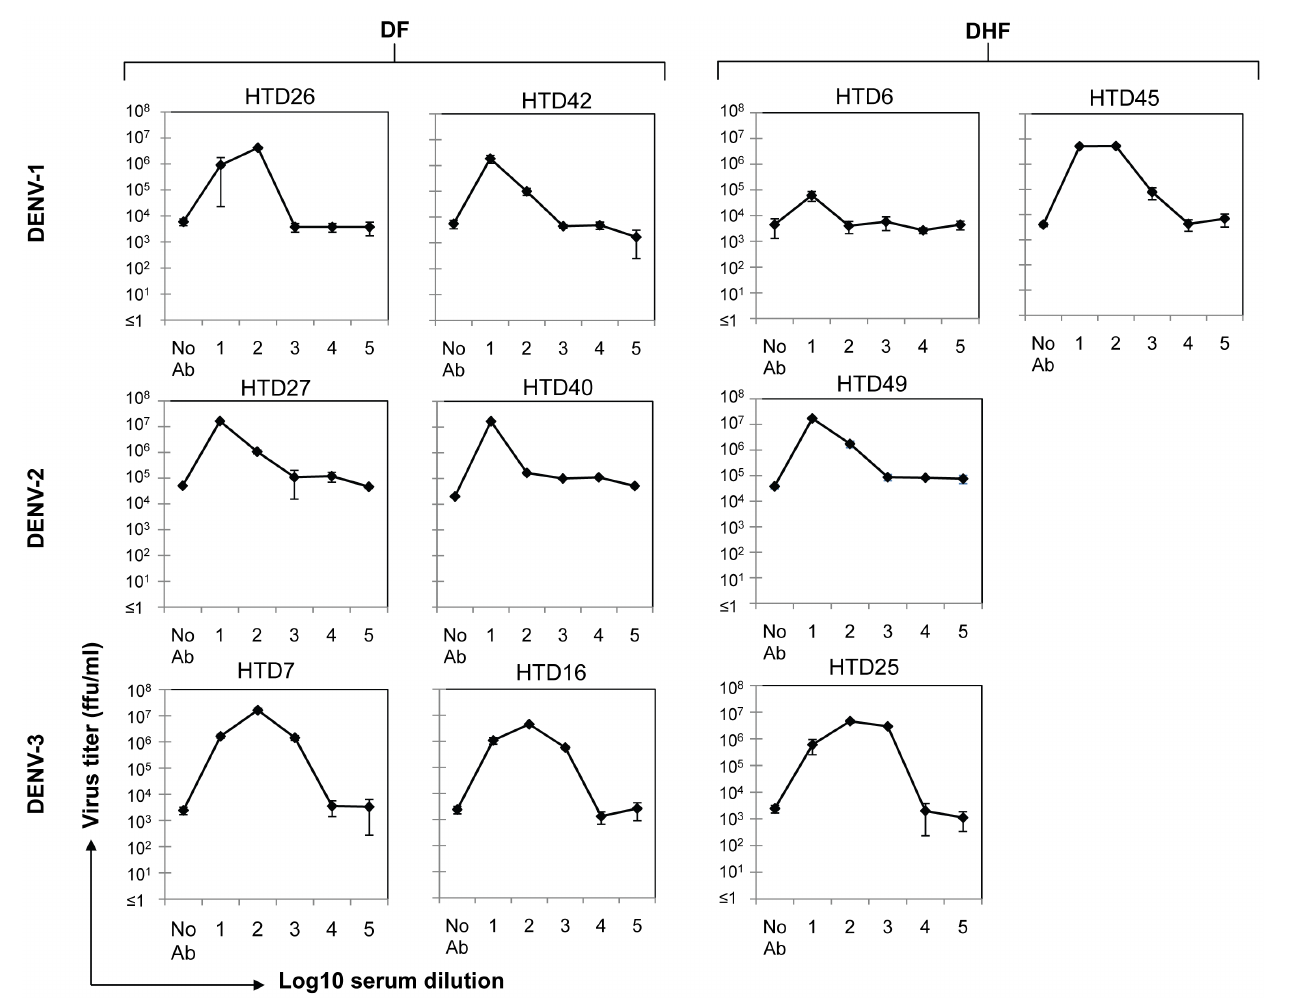
Figure 3. High levels of ADE when using patient plasma and laboratory-culture adapted DENV. Ultracentrifugation supernatants of patient sera were heat-inactivated at 56 u C for 30 min, diluted 10-fold, and pre-mixed at an MOI of 0.02 with laboratory culture-adapted DENV-1, -2, and -3 for 30 minutes at 37 u C. Virus-antibody complexes were added to K562 cells and incubated for 2 hours at 37 u C. Maintenance medium supplemented with 2% FBS was then added before a further incubation for 3 days. Supernatants were harvested for virus titration in focus-forming immunoassays in Vero cells. Results are expressed as the mean 6 SD of triplicate experiments. ‘No Ab’ means virus infection in the absence of plasma. The ‘No Ab’ value was used as a base line for calculating virus infection